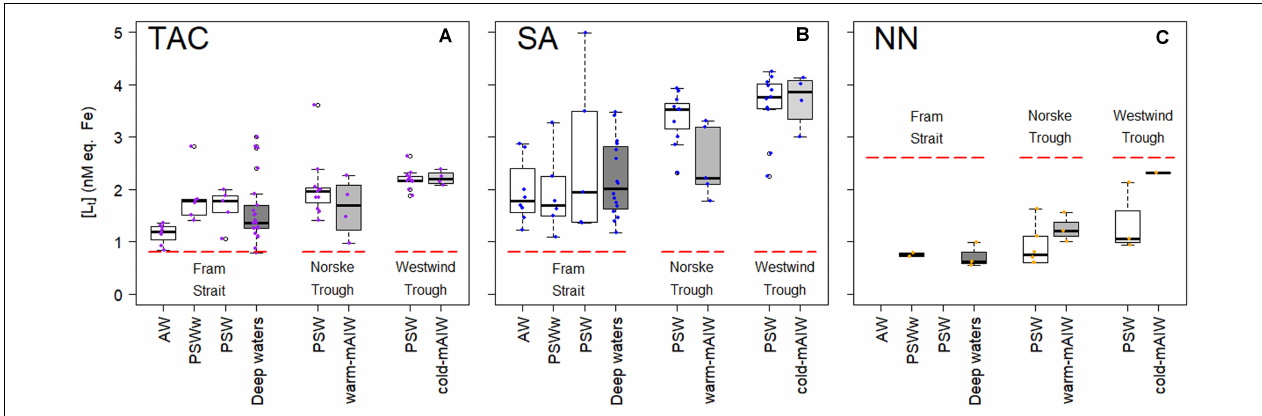
FIGURE 2 | Box plot of ligand concentrations, [L t ], in nM eq. Fe from three different applications of added ligands (A) TAC, (B) SA, and (C) NN, as fitted (non-linear) by a one-ligand model using the Langmuir isotherm. The data is grouped by the biogeochemical provinces as described by Ardiningsih et al. (2020). A thick horizontal line indicates the median, the box contains the first to third quartiles, the whiskers are the range of data excluding the outliers and the circles indicate the outliers being 1.5* interquartile range from the box (Teetor, 2011). Figures were made using the software package R. TABLE 2 | Summary of the mean and median total ligand concentrations [L t ], conditional stability constants log K (cid:48) Fe (cid:48) L , and the side reaction coefficients log , from the three applications of added ligands (TAC, SA and NN) according to the one-ligand model. one-ligand model